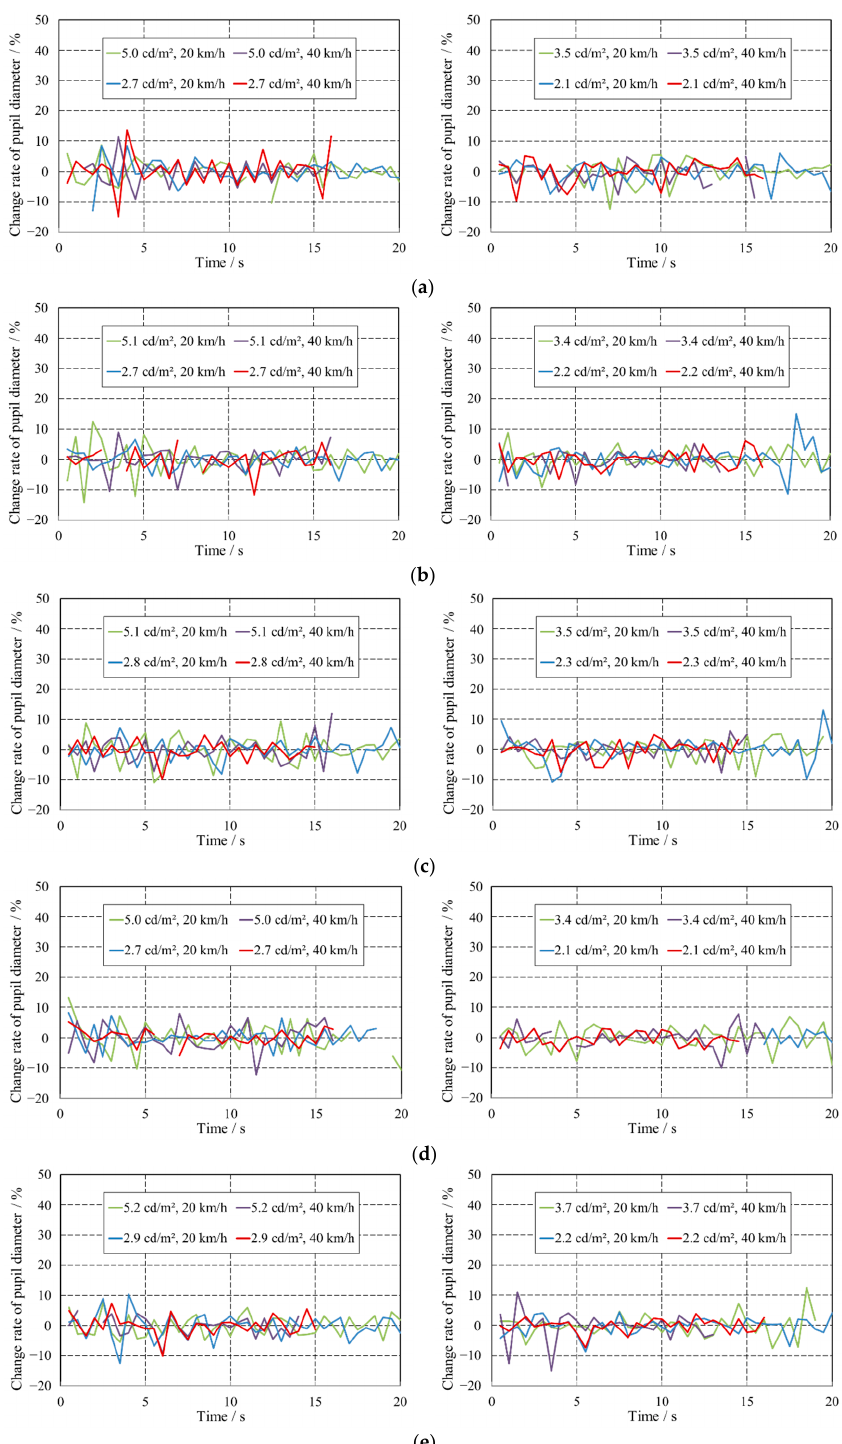
Figure 11. Change rate of driver’s pupil diameter (left: sidewalls with energy-storage and luminescent coating; right: sidewalls with gray cloth). ( a ) 2500 K, ( b ) 3500 K, ( c ) 4500 K, ( d ) 5500 K, ( e ) 6500 K.